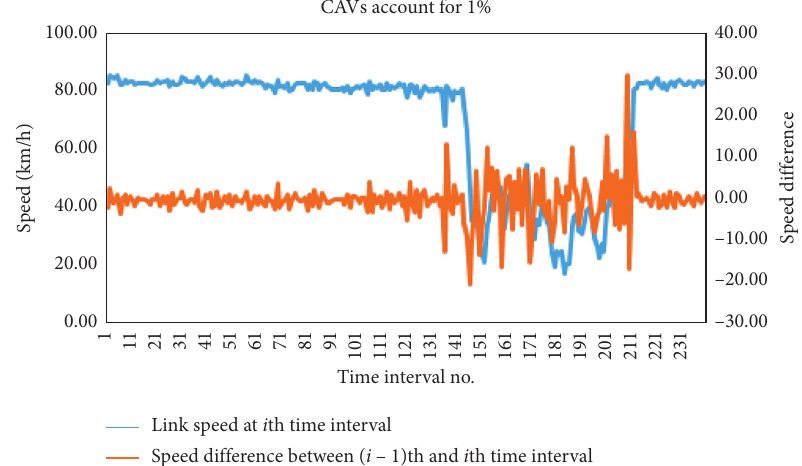
Figure 5: An example for speed difference between ( i –1)th and i th time interval.